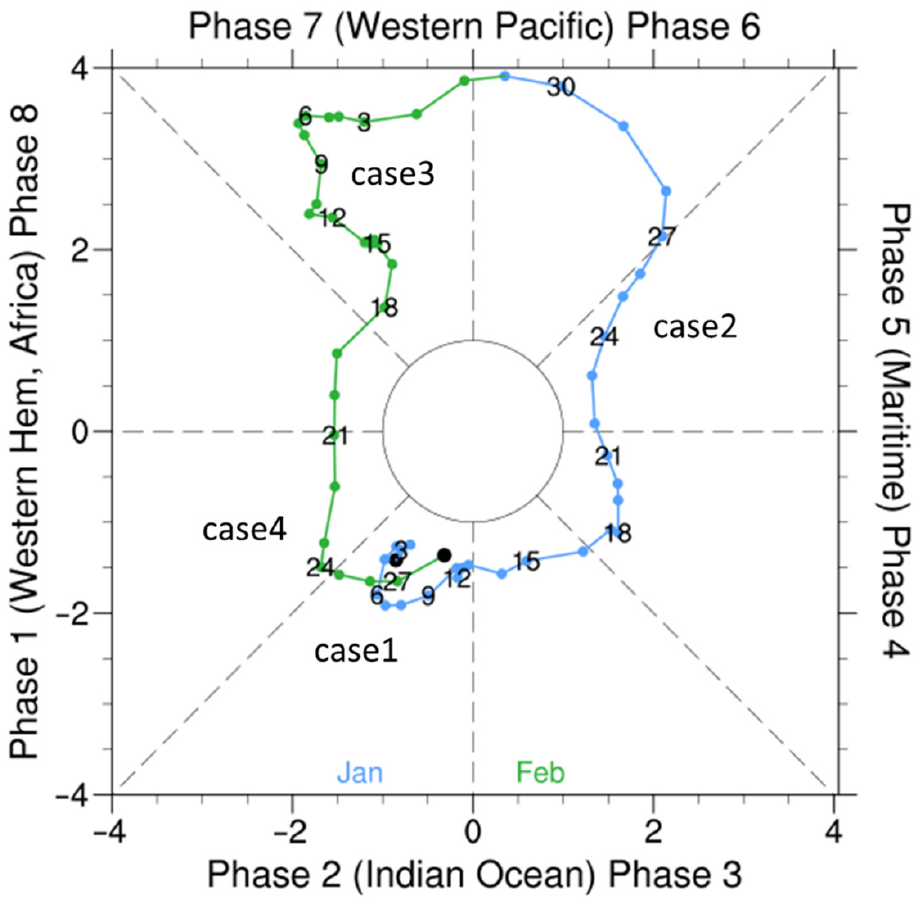
Figure 1. MJO RMM phase diagram for January (blue)–February (green) 2018 with locations of the 4 6-h cases attached.